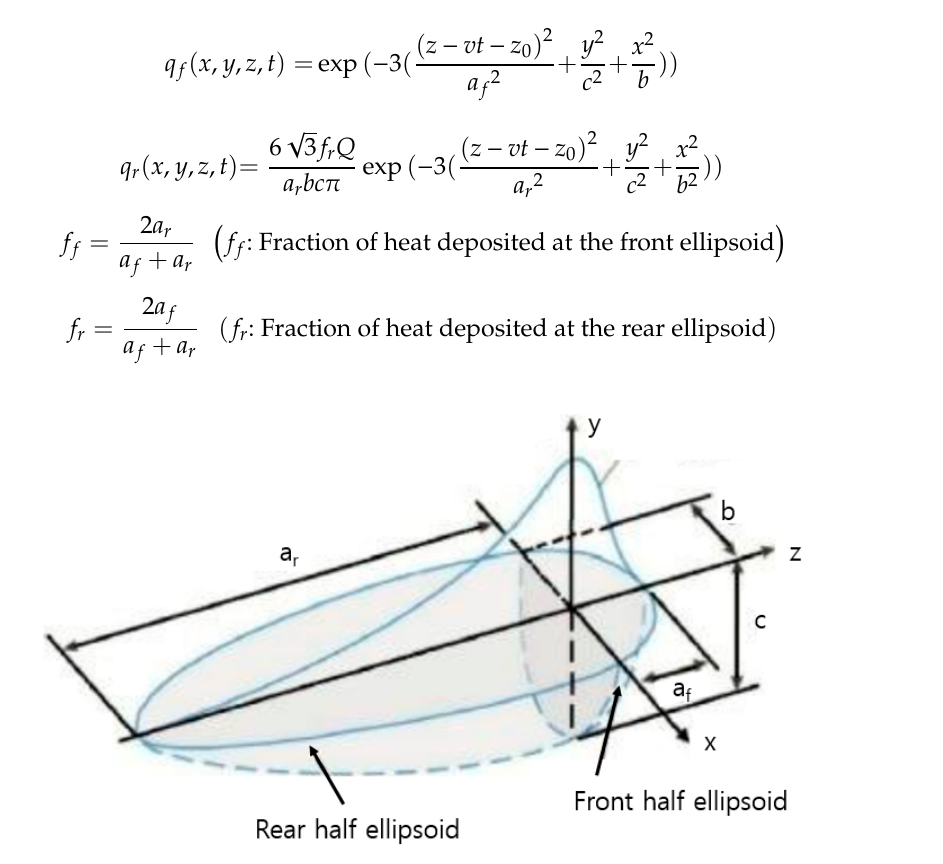
Figure 1. Heat distribution of Goldak model [9].